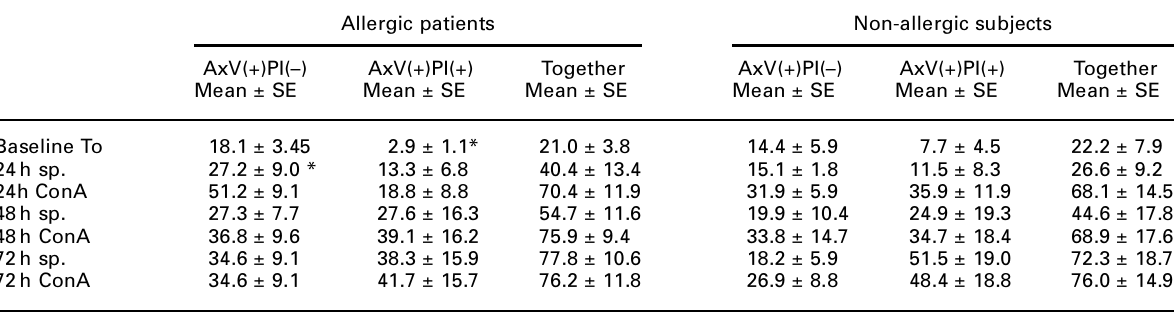
Table 3. Apoptosis of MNC in allergic patients ( n = 3) and non-allergic subjects ( n = 3) examined by cytofluorymetry with Annexin V-FITC and PI. (AxV- Annexin V, PI- Propidium Iodine, SE- standard error, Sp.- spontaneous).